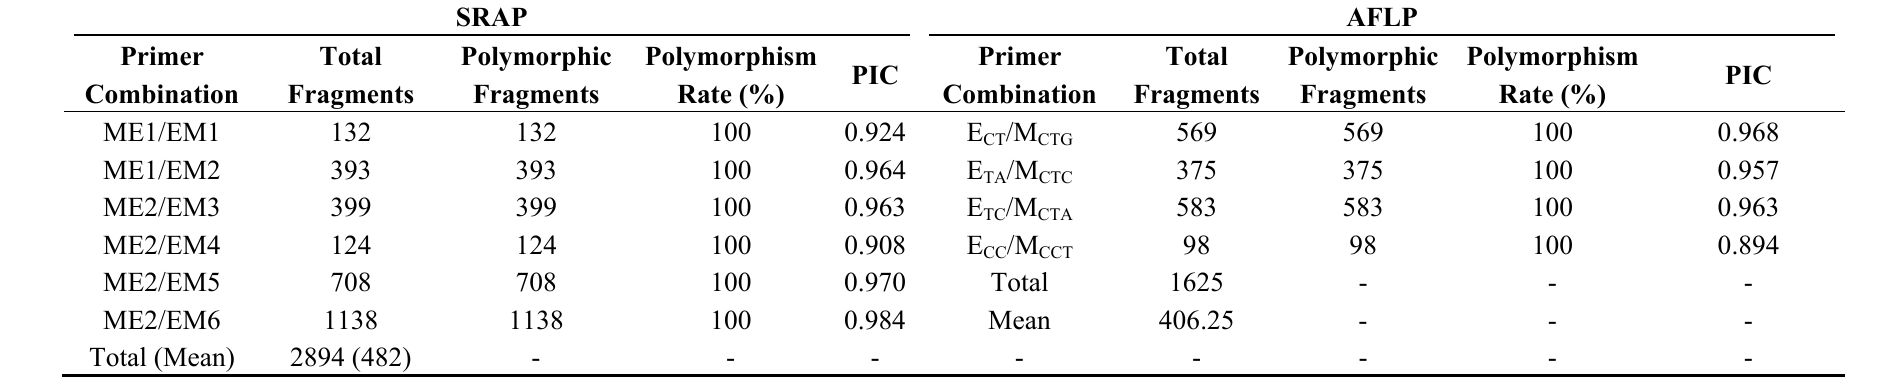
Table 5. Summary of sequence-related amplified polymorphism (SRAP) and amplified fragments length polymorphism (AFLP) primers combinations results. PIC: polymorphic information